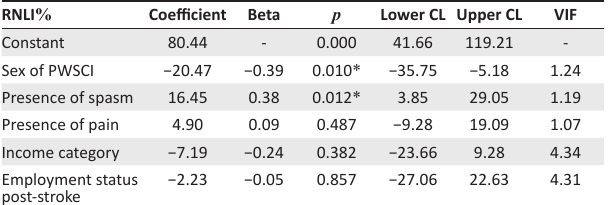
TABLE 5: Determinants of community reintegration using multiple linear regression relating Reintegration to Normal Living Index % to predictor variables ( n = 41).